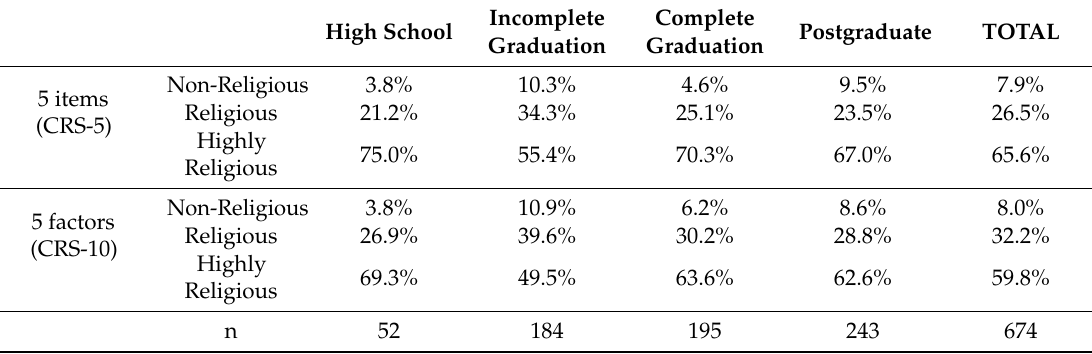
Table 10. CRS categorization between educational